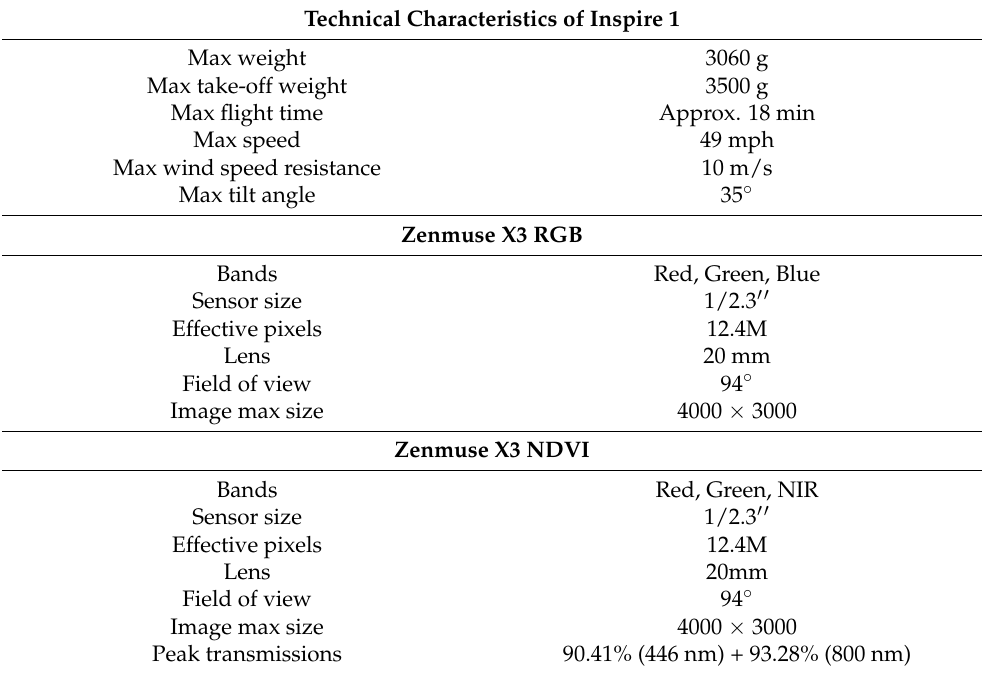
Table 1. Technical characteristics of DJI Inspire 1, RGB, and NDVI modified